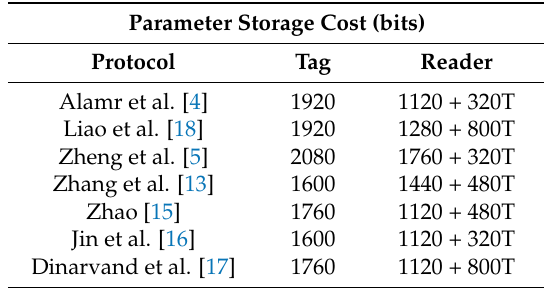
Table 3. Comparison of storage needed in tag and